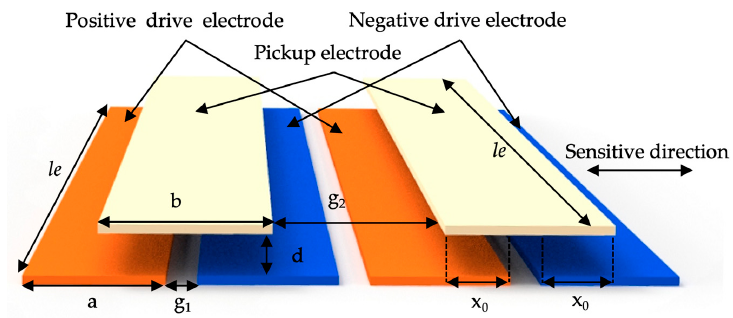
Figure 4. Schematic of the area-variation capacitive displacement transducer configuration. Table 3. Design parameters of the periodic array area-variation capacitive displacement transducer.